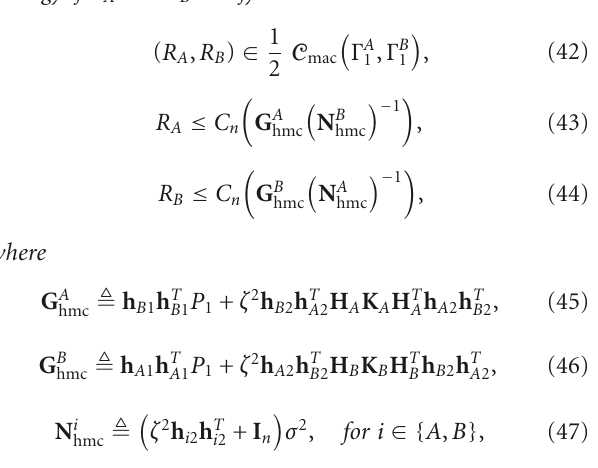
( (cid:11) m A , (cid:11) m B ). 1